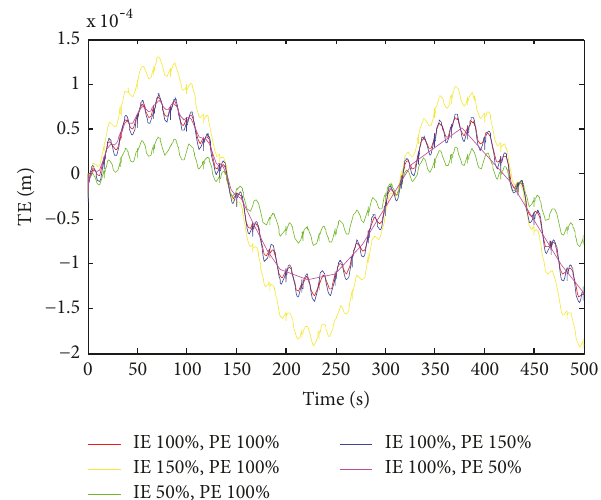
Figure 15: Effect of the amplitude parameters of PE and IE on LTE.